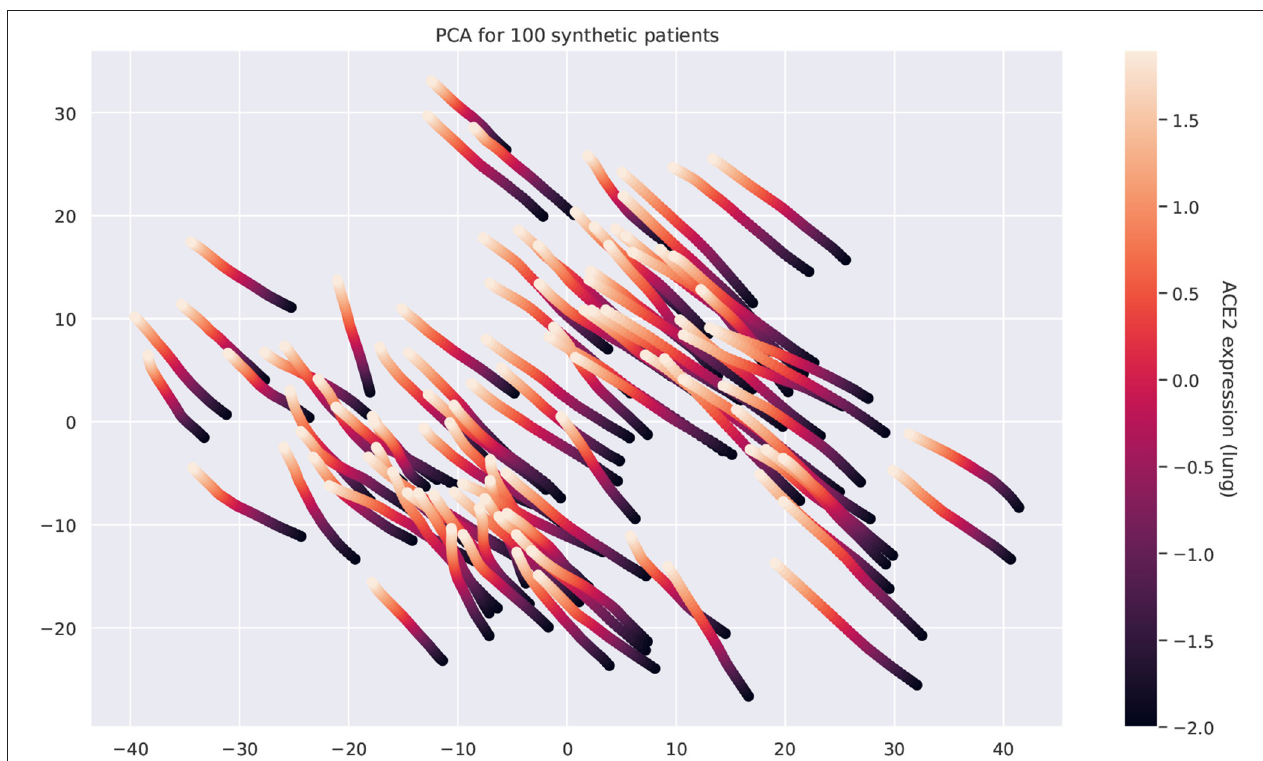
FIGURE 12 | Principal component analysis of the multi-tissue expression of 100 synthetic patients for different levels of ACE2 expression. Each line corresponds to a unique patient. For each patient, we fix all the latent covariates and modify the levels of ACE2 in lung. Overexpressing ACE2 leads to changes in the expression of other genes and these changes follow a well-defined